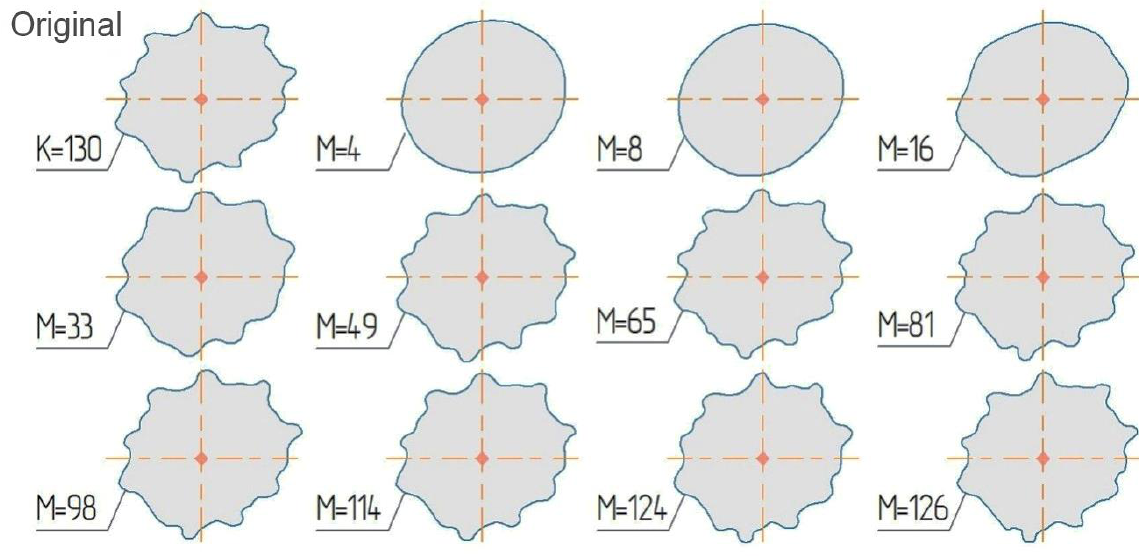
Figure 12. Restoring contour outlines by the number of Fourier coefficients